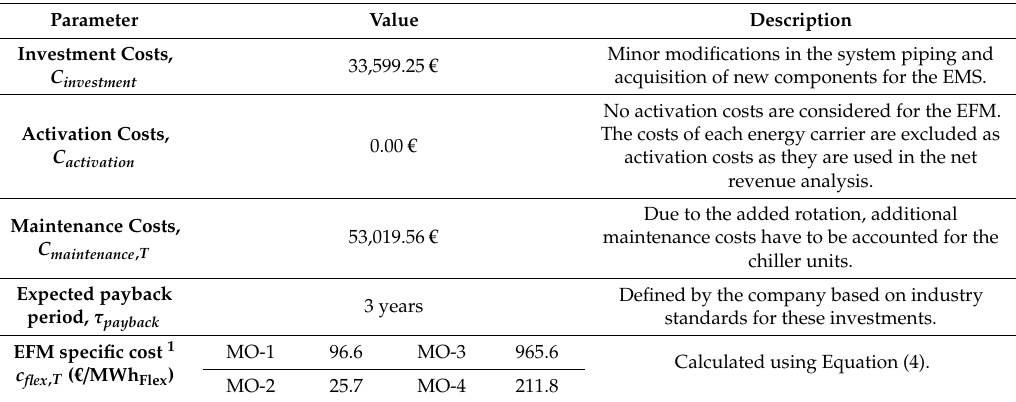
Table 10. Economic Dimension of the identified